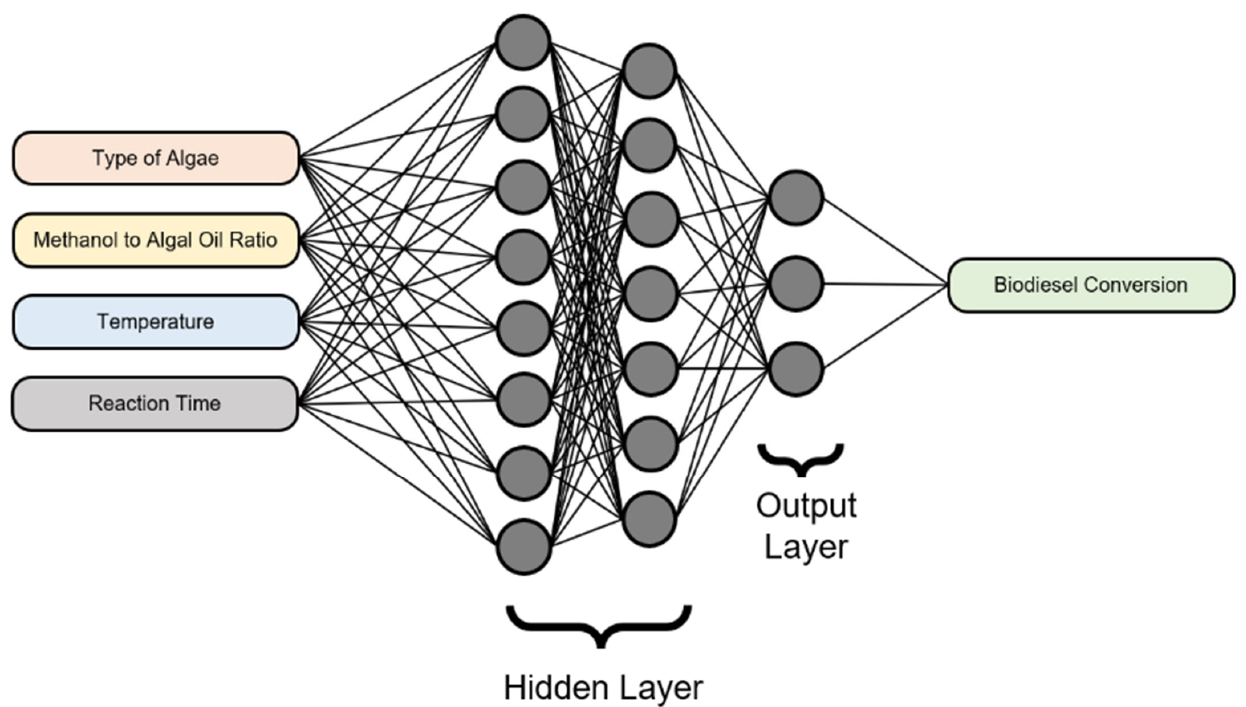
Figure 1. Illustrative representation of the artificial neural network design developed for the N2IC model.